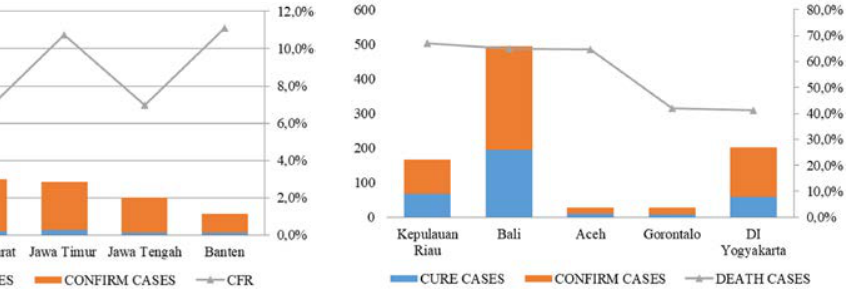
Fig. 2. Five provinces with the highest case fatality rate (CFR) in